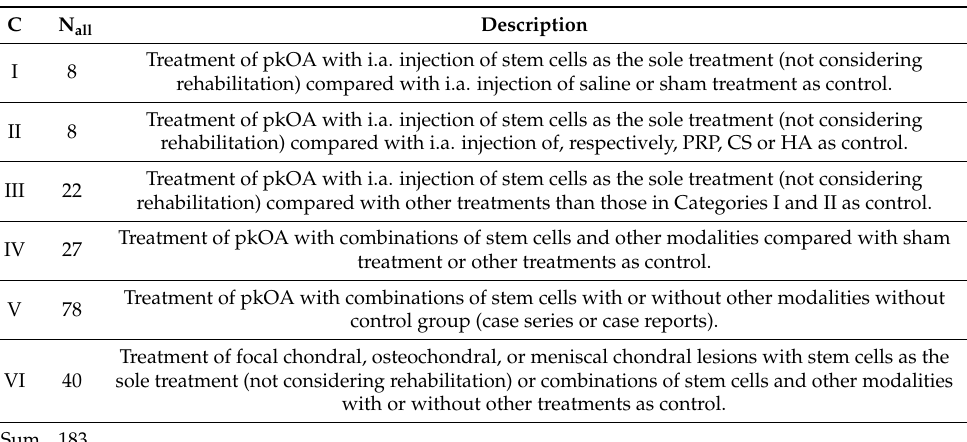
Table 6. Categories of studies on treatment of primary knee osteoarthritis with stem cells that were identified during an evidence-based, systematic review of the literature according to the PRISMA guidelines [198] performed on 7 August 2021 (summarized in Table